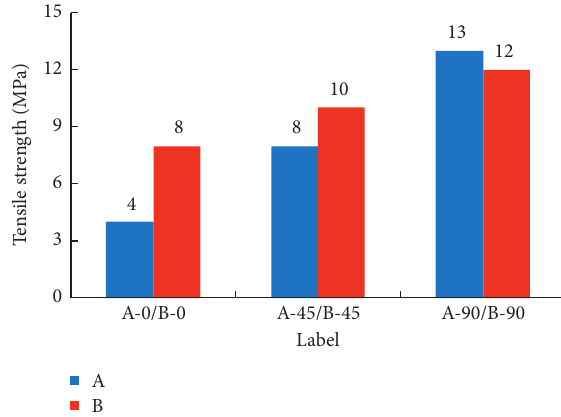
Figure 9: Tensile strength of test